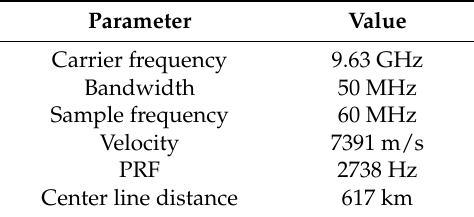
Table 1. Simulation parameters of the spaceborne